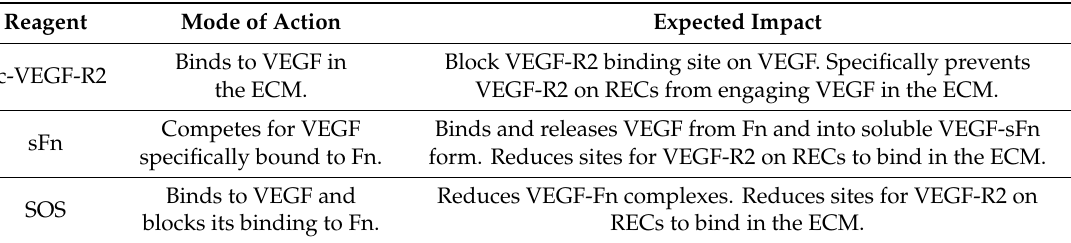
Table 1. Summary of VEGF-ECM Antagonists.